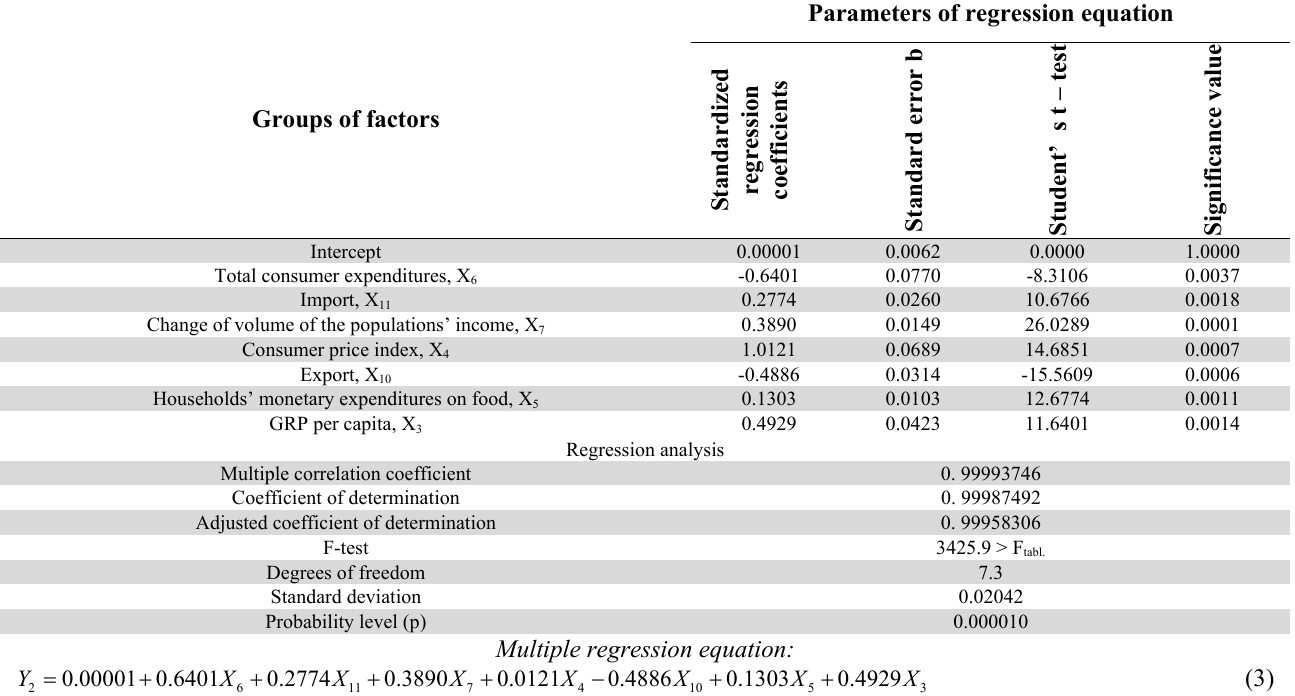
Results of the regression analysis of the consumer capacity of the regional food market in Zakatpatska oblast and socio-economic factors